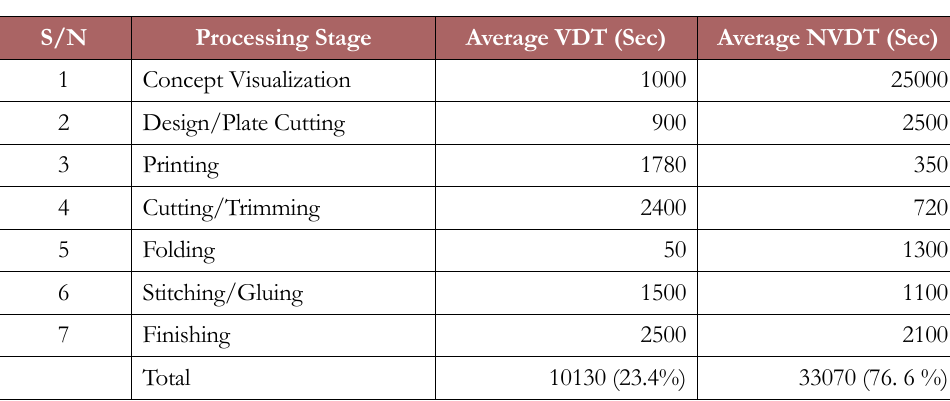
Table 2. Existing Value Added and Non-Value-Added Time of the production line